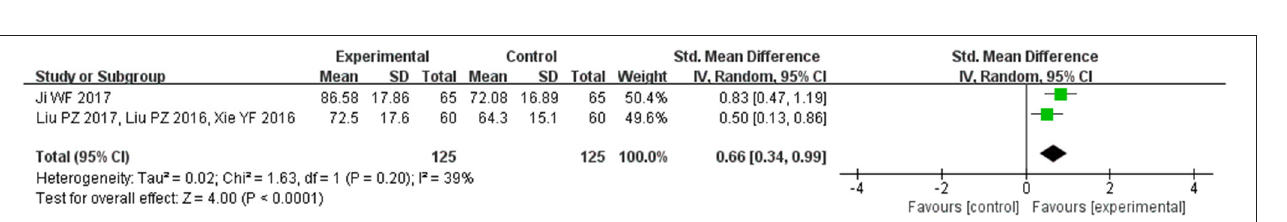
FIGURE 5 | Forest plot of the comparison between CHM and control for quality of life as measured by the MLHFQ.